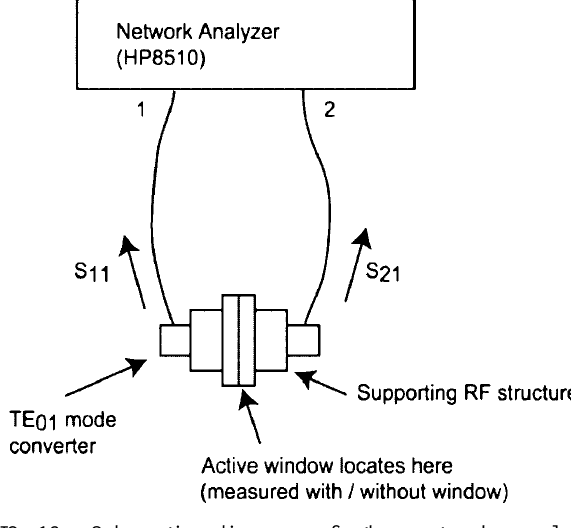
FIG. 13. Schematic diagram of the network analyzer measurement.